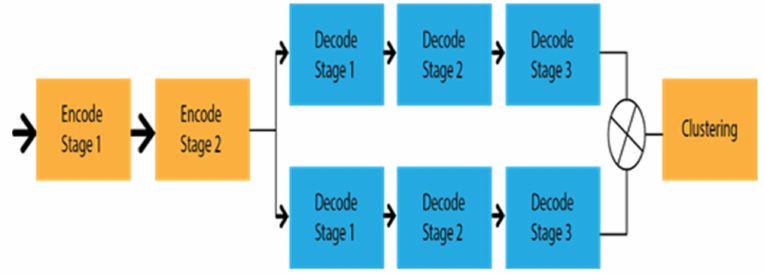
Figure 12. Schematic diagram of